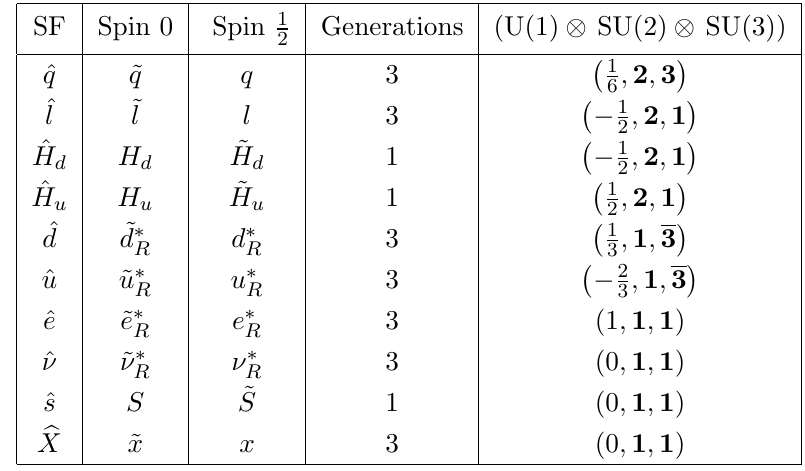
Table 1 . Chiral super(cid:12)elds in the NMSSM with inverse seesaw mechanism. Fourth, the (cid:12)elds H 0 and S acquire their vevs after electroweak symmetry breaking, u;d